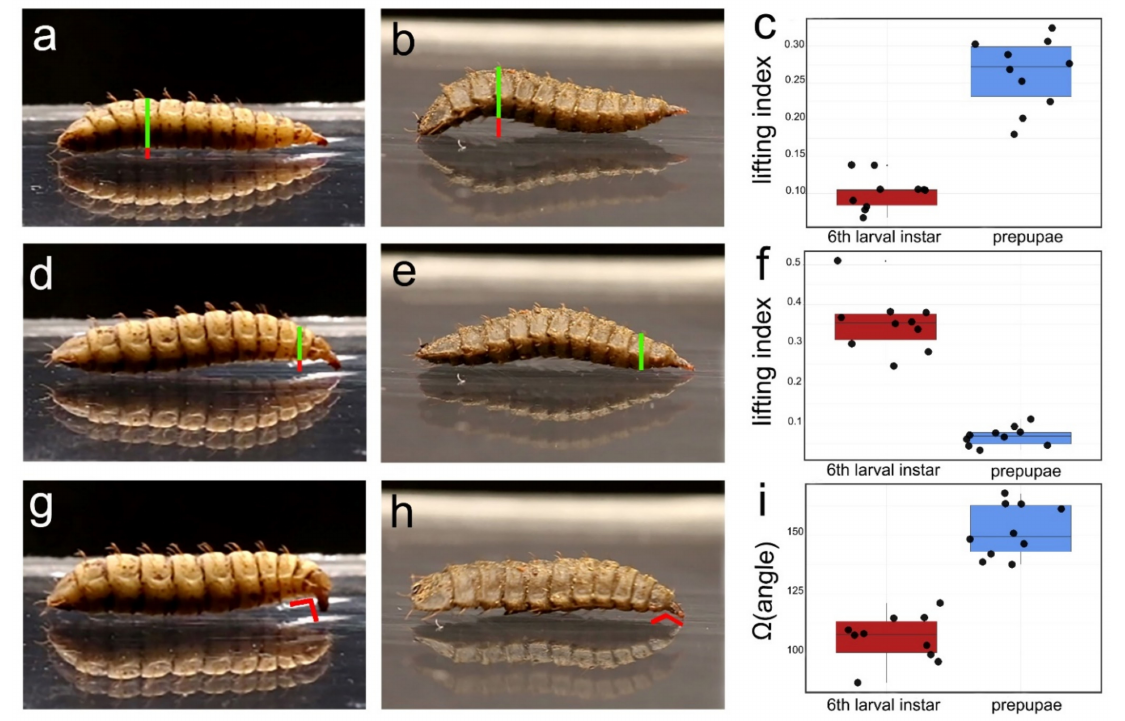
Figure 4. Movements in the locomotory pattern of 6th instar larvae ( a , d , g ; n = 10) and prepupae ( b , e , h ; n = 10) and analysis of their differences through measurements ( c , f , i ). Each row corresponds to one of the three movements: i = when the larva stretched its head forward ( a , b ), ii = when the head then touched the surface before being used as a pin to crawl forward ( d , e ); iii = when the head is used as a pin to crawl forward ( g , h ). In pictures ( a – e ) the red line and green lines indicate the measured characters (the length of the red line is divided for the length of the green one to compute the lifting index), in pictures ( g , h ) the measured angle is indicated in red.